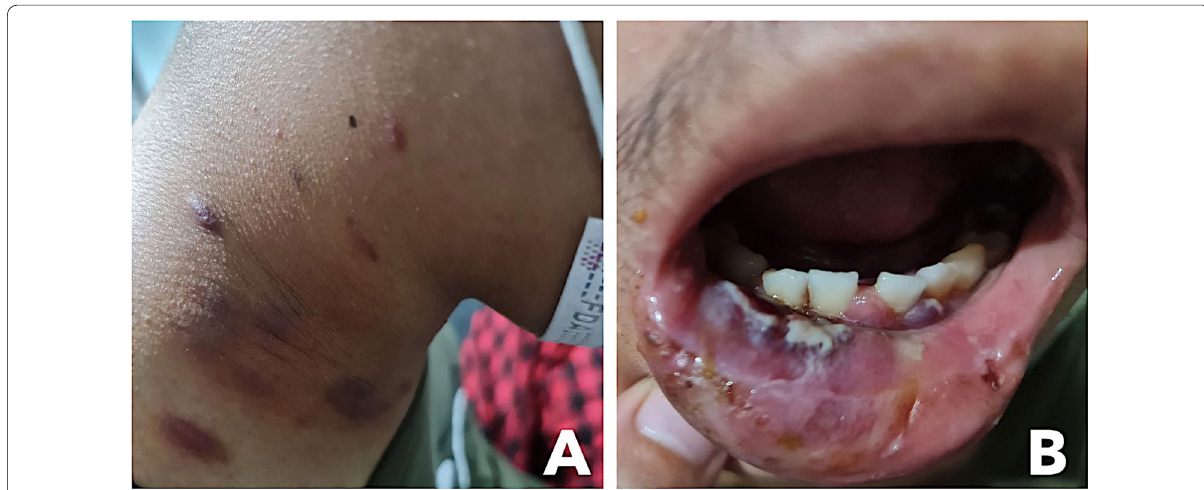
Fig. 1 Multiple violaceous non‑tender patches, plaques, and nodules on the neck ( A ) and purplish bruise‑like mass and ulceration of the right lower lip ( B )